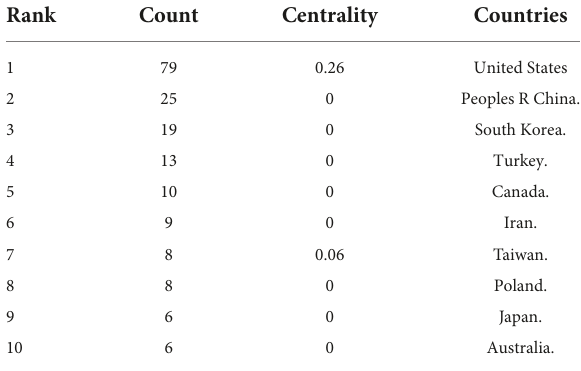
TABLE 1 Top 10 countries/regions related to PMD.